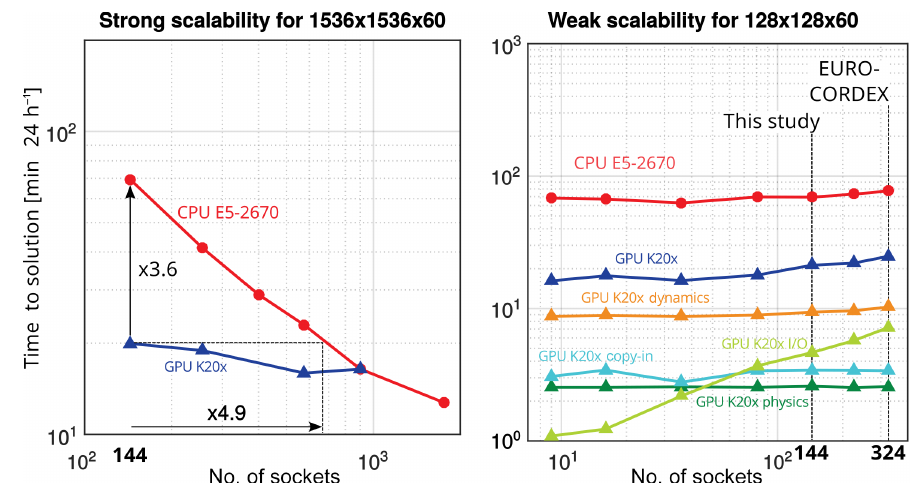
Figure 12. Time to solution for a 24h simulation for execution on CPUs architecture (red) and on the same number of GPUs (blue). (Left) strong scaling for a domain with 1536 × 1536 × 60 grid points. The number of sockets is increased while keeping the problem size fixed. (Right) weak scaling with a per-node size of 128 × 128 × 60 grid points. Increasing problem size while keeping the grid points per socket constant. Contributions form several modules: (orange) dynamics, (dark green) physics, (light green) input/output, and (light blue) data copy to and from